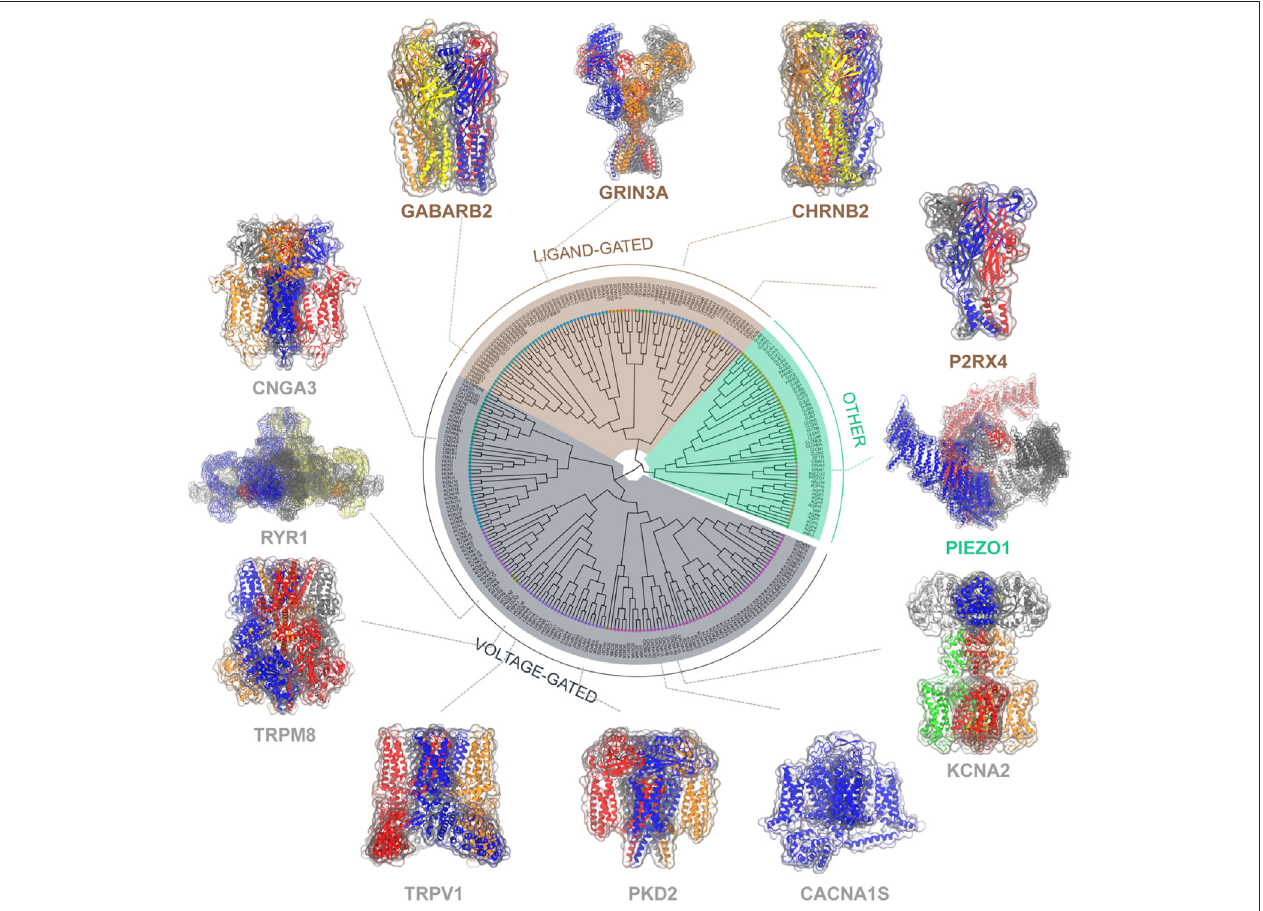
FIGURE 1 | Classi fi cation of ion channels based on activation mechanisms and structural similarities. The evolutionary relationships among these ion channels are measured by the phylogenetic tree of ion channels (Alexander et al., 2019) with representative channel structures (center). Representative ion channels selected from each class are shown with their 3D molecular